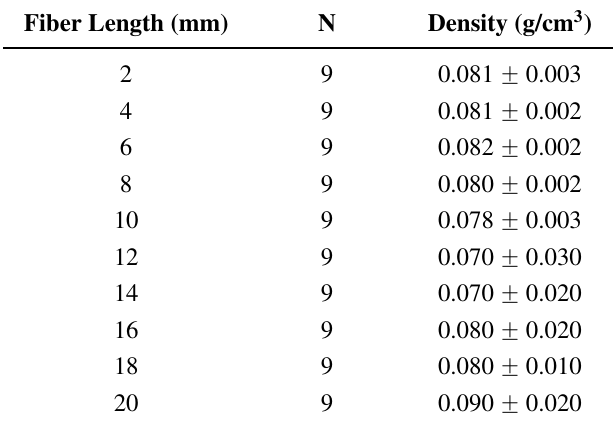
Table 3. Average densities for each fiber length of the soy silk compression series samples.